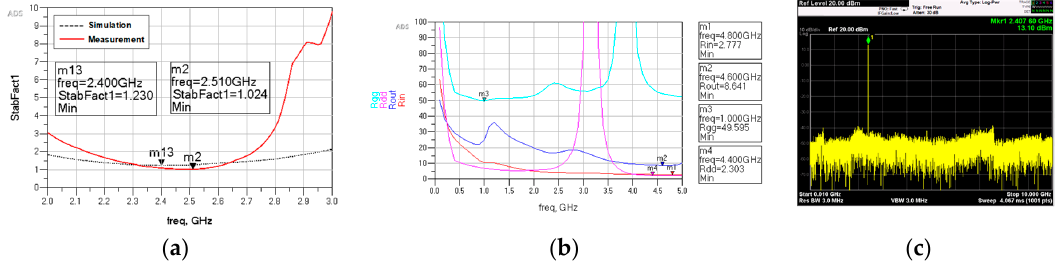
Figure 4. ( a ) Comparison Rollet’s factor between simulation and measurement ( b ) Determination of negative resistance from real part of gamma ( c ) The measurement data of frequency spectrum from DC to 10 GHz.